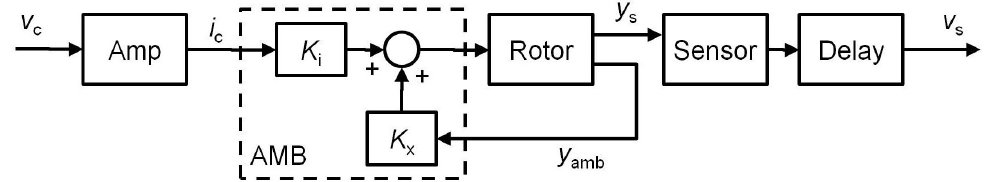
Figure 15. Radial AMB system block